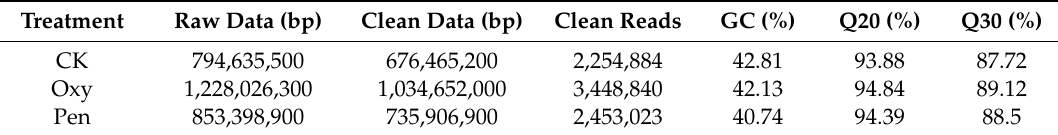
Table 1. Summary of metagenome